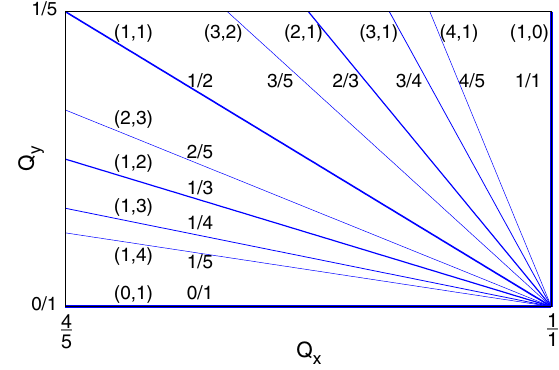
FIG. 2 (color online). Graphical representation of the resonance sequence of order 5 attached to 1 = 1 . The resonance lines are represented by ð a; b Þ and the corresponding Farey fraction by p=q . Note that ð a; b Þ ¼ ð p; q − p Þ . The free term c to complete the resonance equation is c ¼ a .